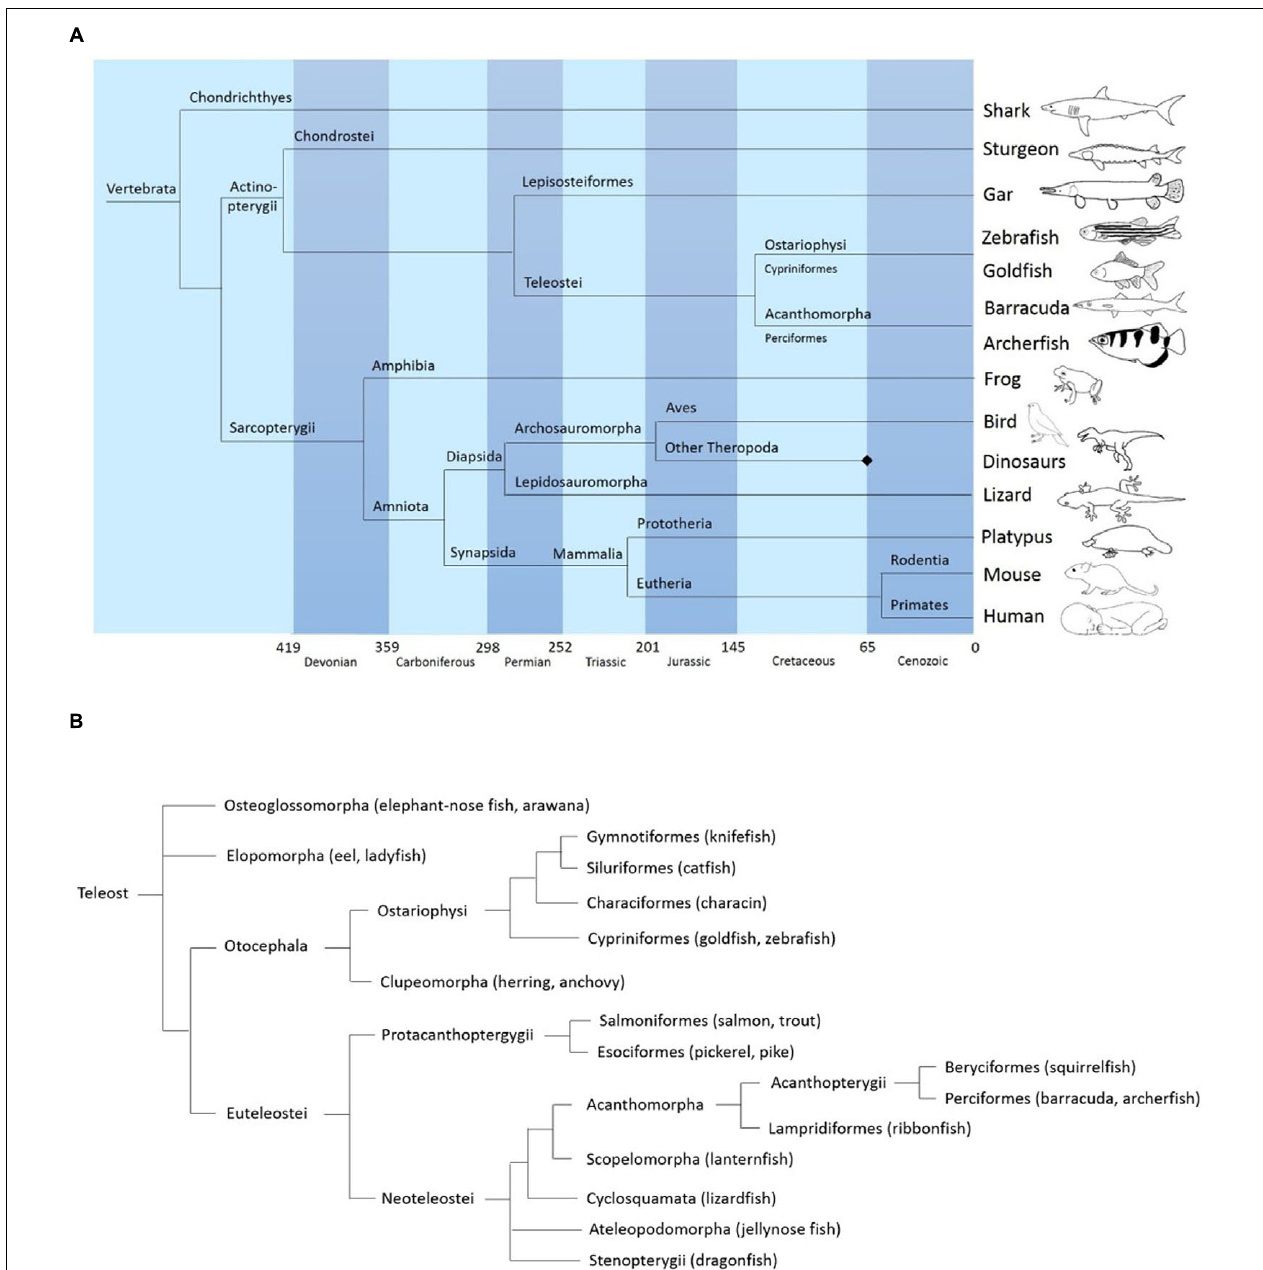
FIGURE 1 | (A) Simplified phylogeny of vertebrates showing the position of acanthomorphs (including the archerfish) relative to other major vertebrate clades. Based on data from “The tree of life web project” (http://tolweb.org/tree/) (see also: Maddison et al., 2007) and Vergleichende und funktionelle Anatomie der Wirbeltiere Hildebrand and Goslow (2013). Springer-Verlag. (B) General phylogeny of teleosts showing the position of archerfish. Based on data from palaeos.com, “The tree of life project,” and Diogo et al. (2008) and Near et al.